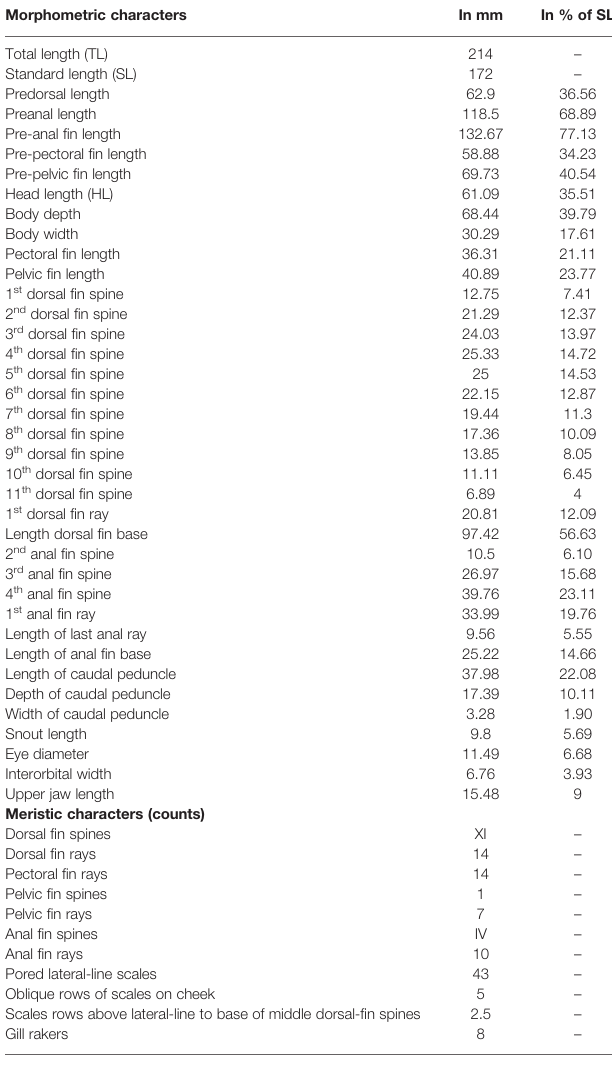
TABLE 1 | Morphometric and meristic characters of Sargocentron caudimaculatum caught out of the Cape Bon locality. Morphometric characters In mm In % of SL Total length